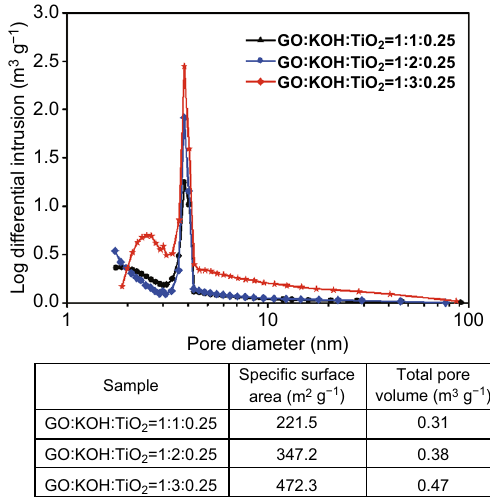
Fig. 5 Specific surface area of the KTO NP/PGC composites pre‑ pared at different weight ratios of GO and KOH (reaction tempera‑ ture: 200 °C, gas flow rate: 10 L min −1 , post‑heat treatment: 700